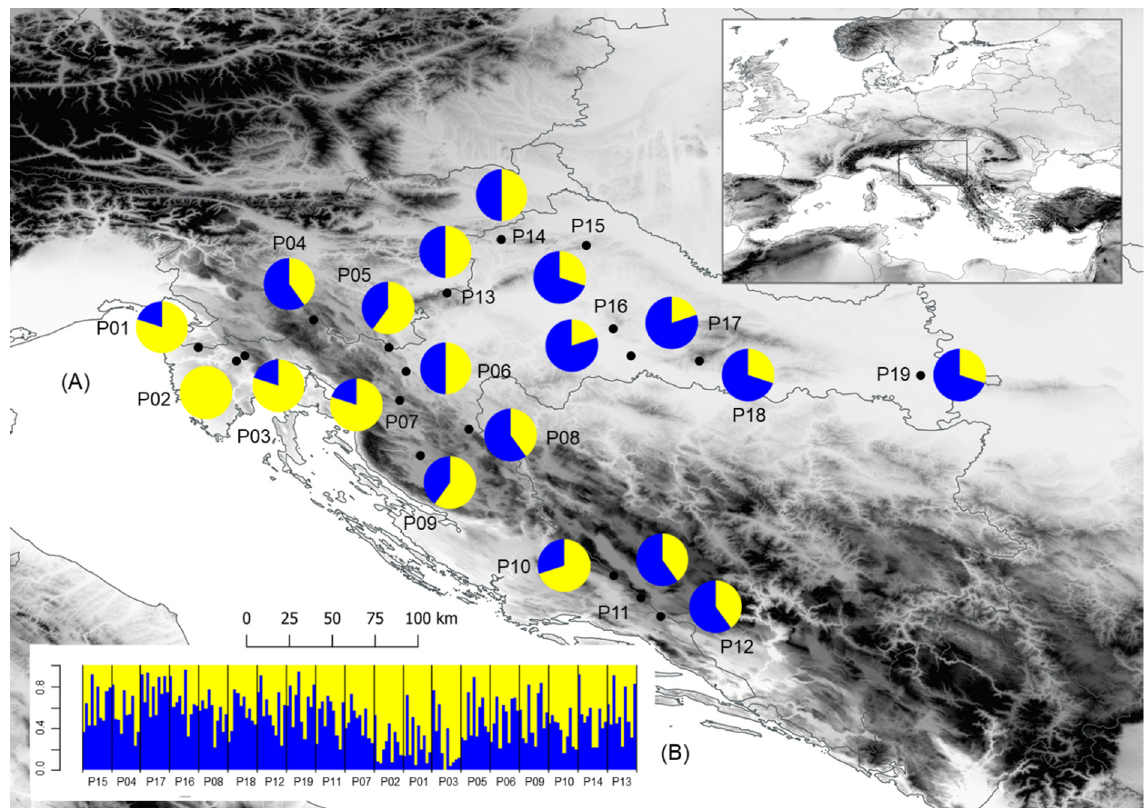
Figure 1. Results of the multivariate statistical methods and locations of the 19 sampled Pyrus pyraster populations, based on 10 morphological leaf traits. ( A ) Geographical distribution of two groups of populations detected from K-means clustering method (the proportions of the membership of each population in each of the defined clusters are color-coded: cluster A—yellow, cluster B—blue); and ( B ) barplot with posterior probabilities of classification of each individual into each group from the results of the classification discriminant analysis. Populations: P01—Kuberton;